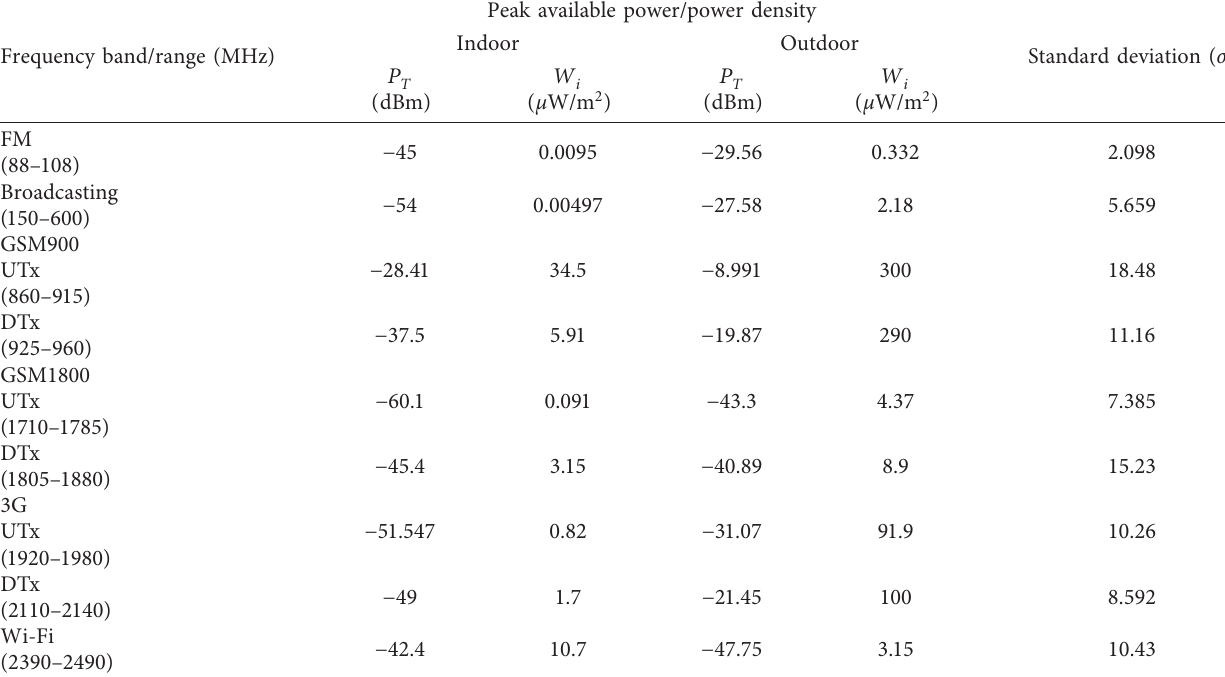
Table 1: Peak ambient power level survey.